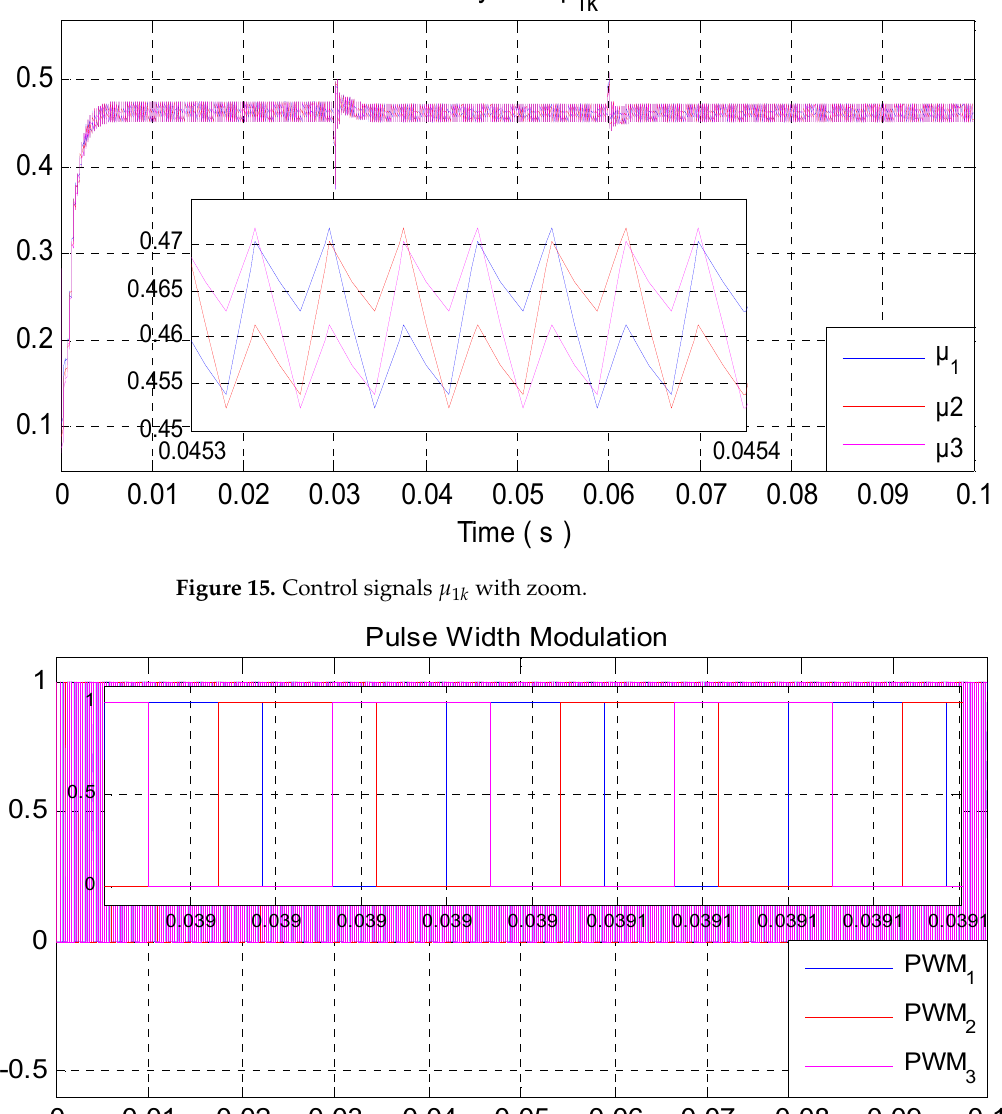
Figure 14. FC internal voltage v i .